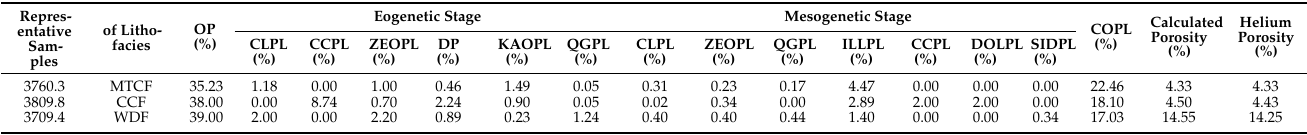
Table 3. The fraction proportion and porosity of different pore types in representative samples of the Toutunhe Formation. Repres- entative Sam-